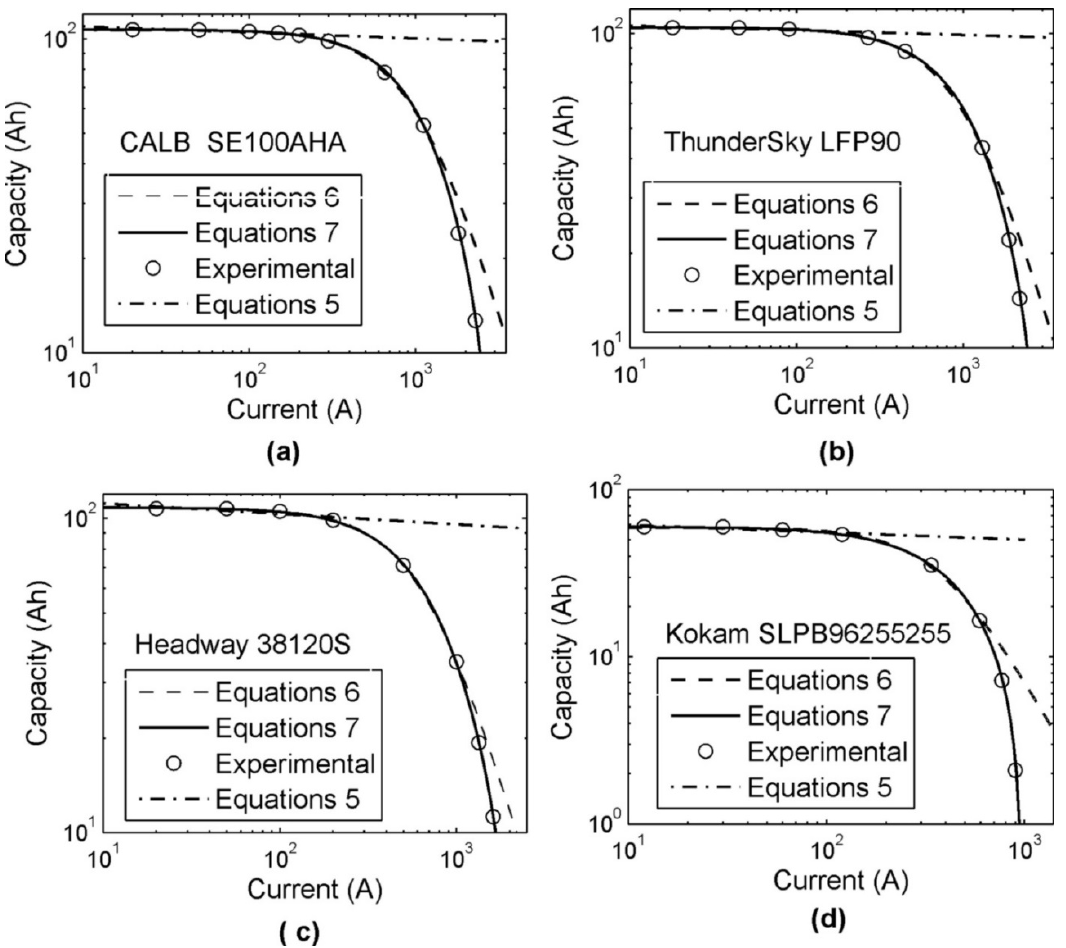
Figure 2. Comparison between Equations (5)–(7) and experimental data for automotive-grade lithium-ion batteries: ( a ) batteries CALB SE100AHA; ( b ) batteries ThunderSky LFP90; ( c ) batteries Headway 38120S; ( d ) batteries Kokam SLPB96255255.